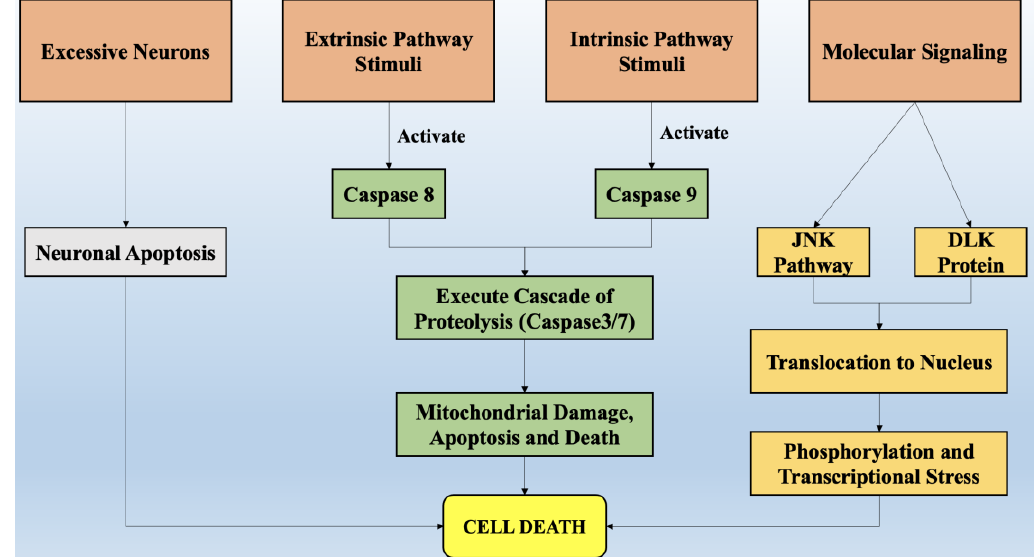
Figure 2. The factors that are involved in the pathways of cell death. Legend: JNK — c-Jun amino-terminal kinase; DLK — dual leucine zipper kinase.